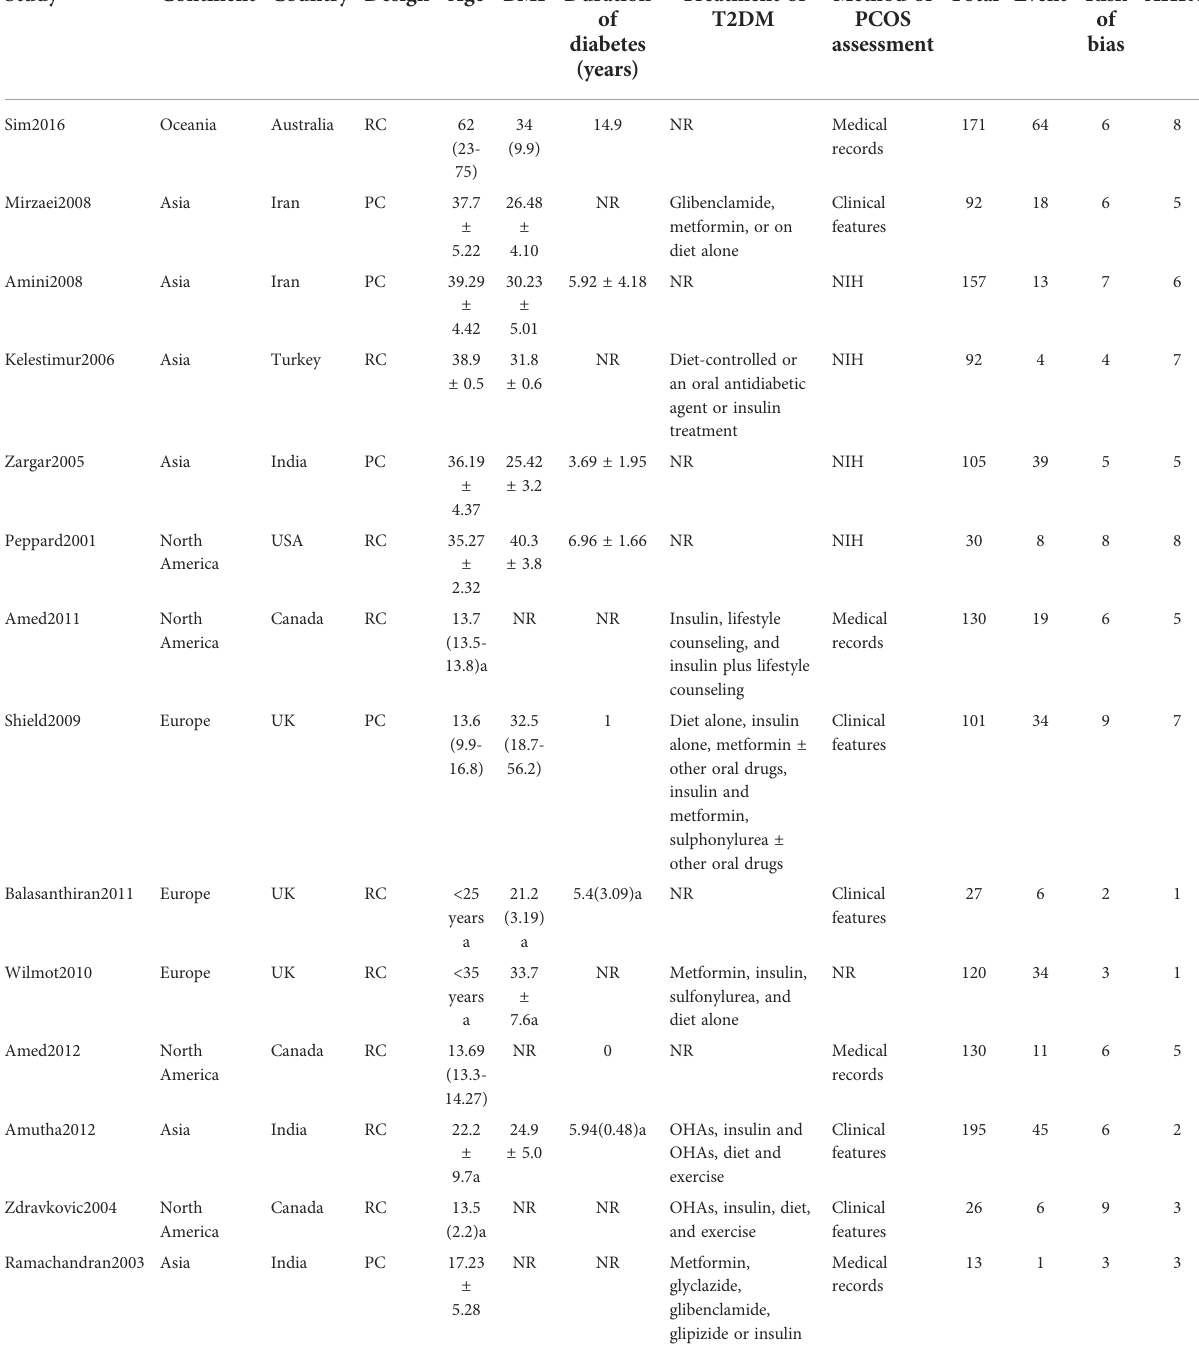
TABLE 1 Characteristics of included